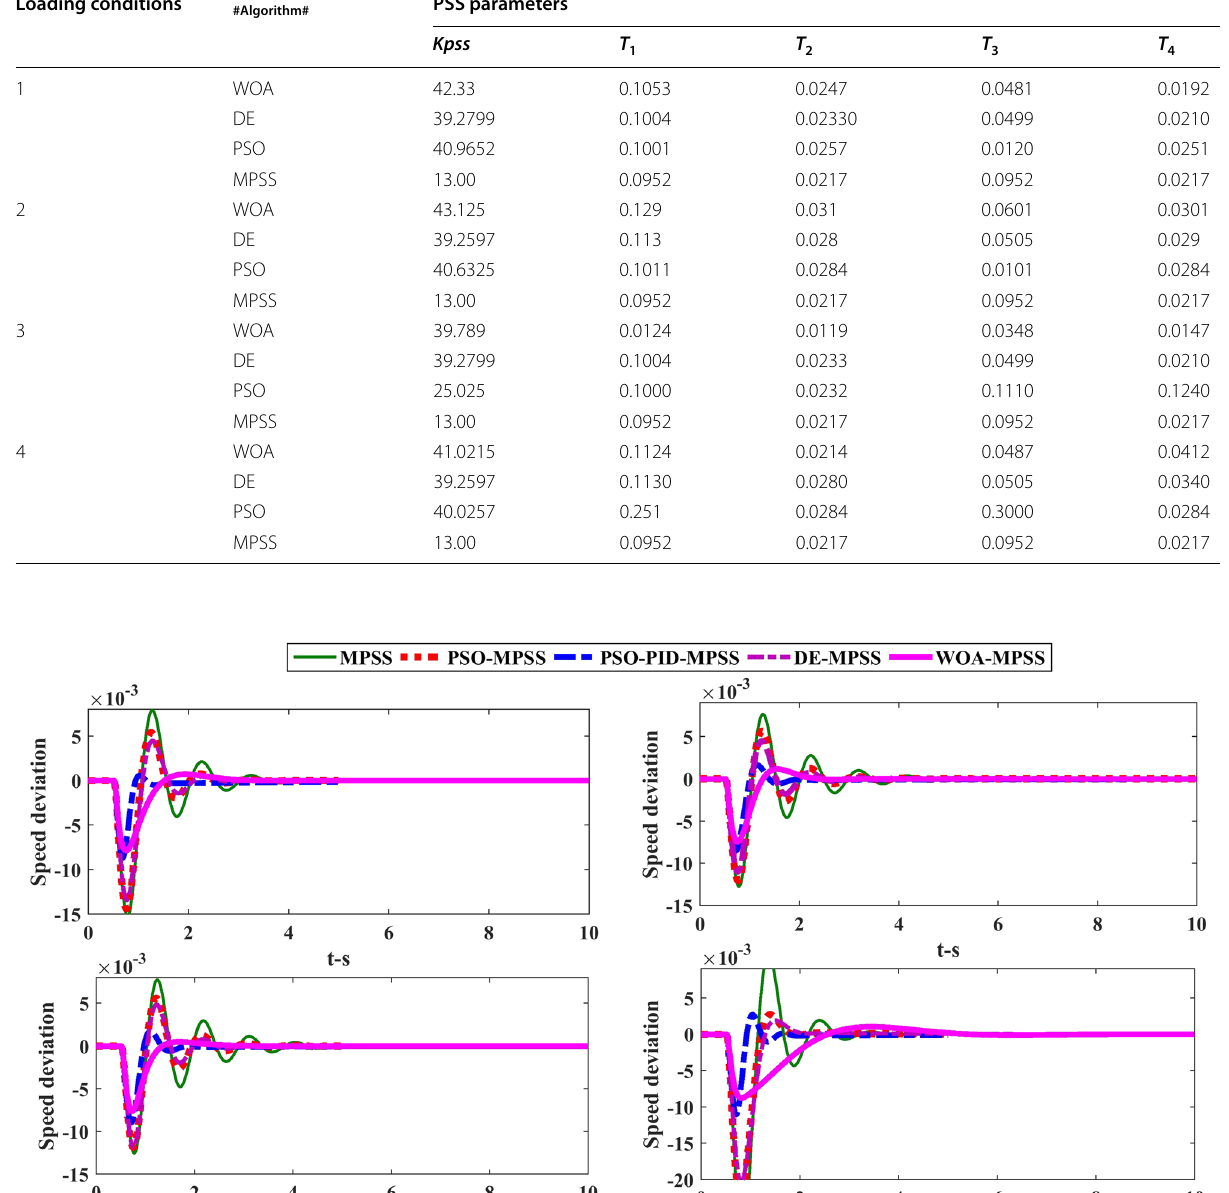
Table 6 Evolved Parameters of PSS for the four loading conditions Loading conditions